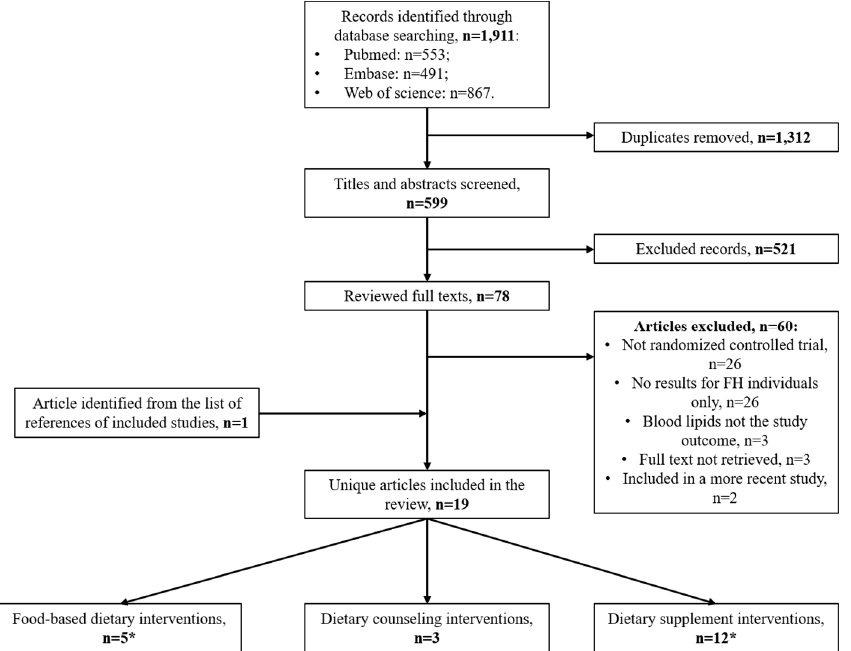
Figure 1. Flow chart of study selection. * The study by Fuentes et al. [19] qualified both as a food-based and a dietary supplement intervention.